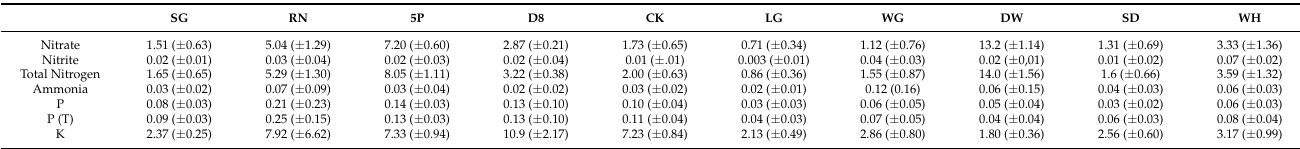
Table 5. Mean nutrient concentration values and standard deviation for each site. Results are reported in mg/L. SG 5P